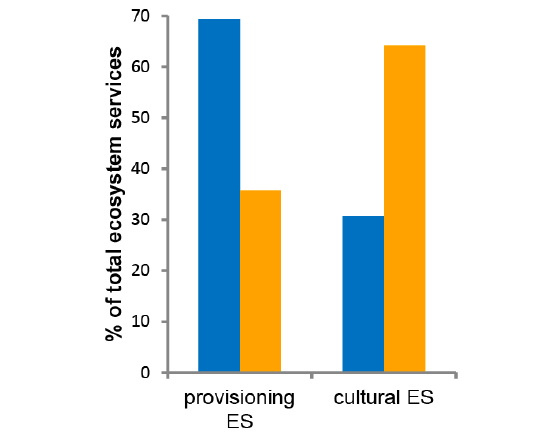
Fig. 4 . Ecosystem services use of the lake area per type for both past conditions (around 1980, blue bars) and current conditions (2015, yellow